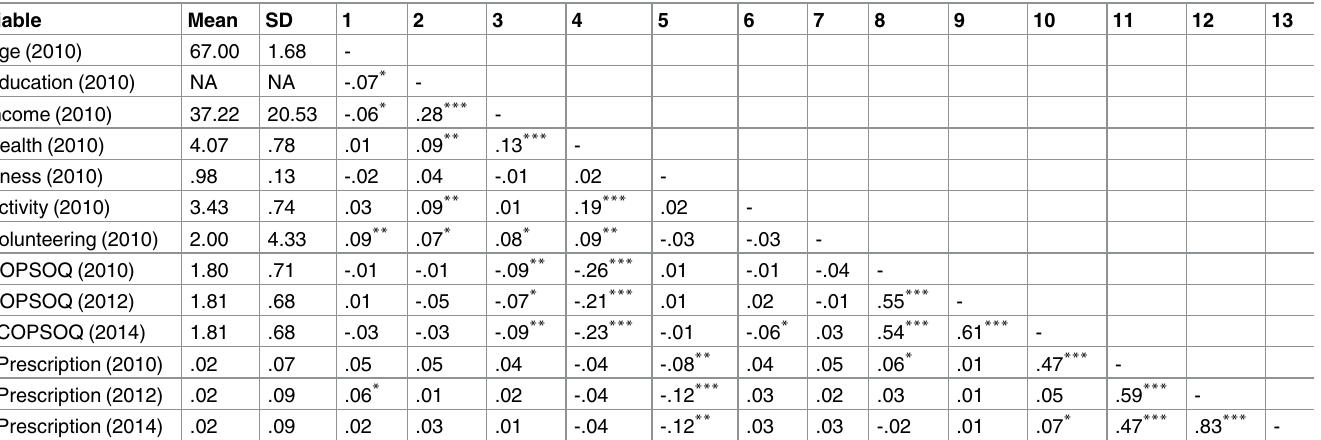
Table 1. Descriptivestatistics and correlations matrix.